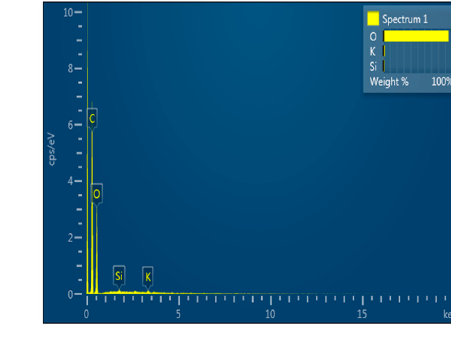
Figure 4. SEM images and EDS spectrum of SCB.